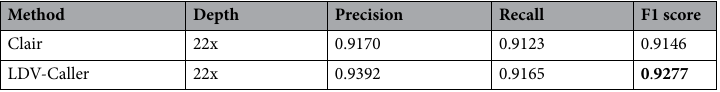
Table 3. Experimental results on SARS-CoV-2 dataset. Significant value in bold.